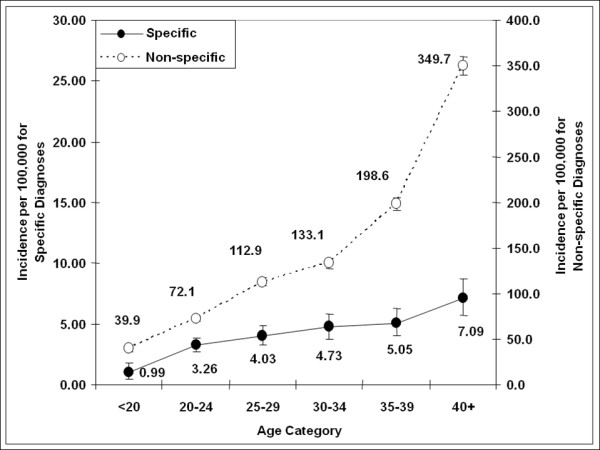
ReA incidence rate (95%CI) by age, category, and diagnosis.